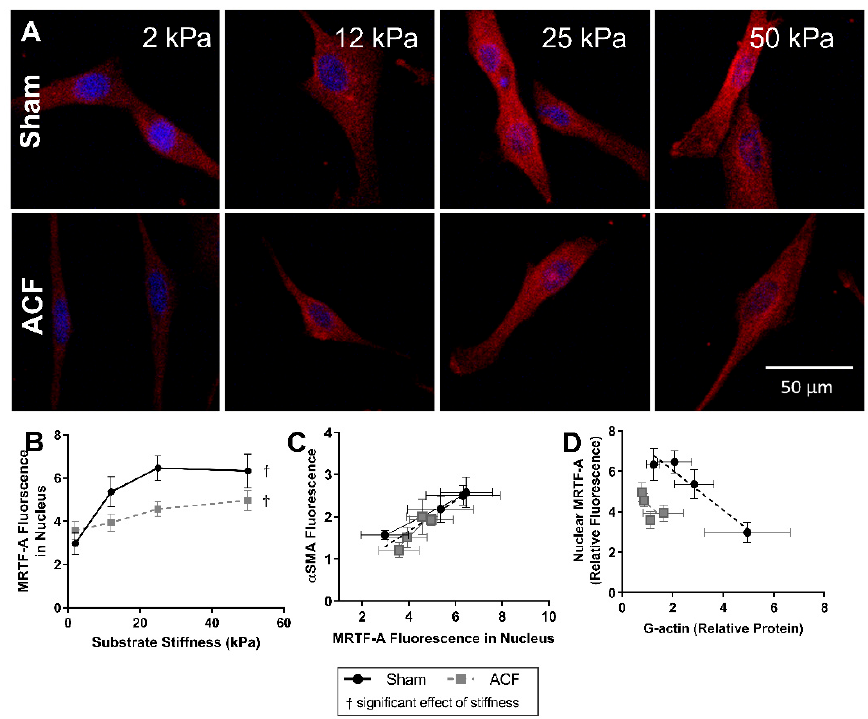
Figure 5. MRTF-A (red) fluorescent localization with DAPI (blue) nuclear counterstain ( A ) and quantification ( B ) in sham and ACF CFs on a range of substrate stiffnesses. MRTF-A nuclear localization is increased with increasing stiffness. ( C ) The relative fluorescence of MRTF-A localized to the nucleus correlates with the relative fluorescence of α SMA fluorescence. ( D ) The relative amount of MRTF-A fluorescence in the nucleus is also inversely related to the amount of G-actin protein quanti fi ed. † indicates a signi fi cant e ff ect of substrate stiffness.